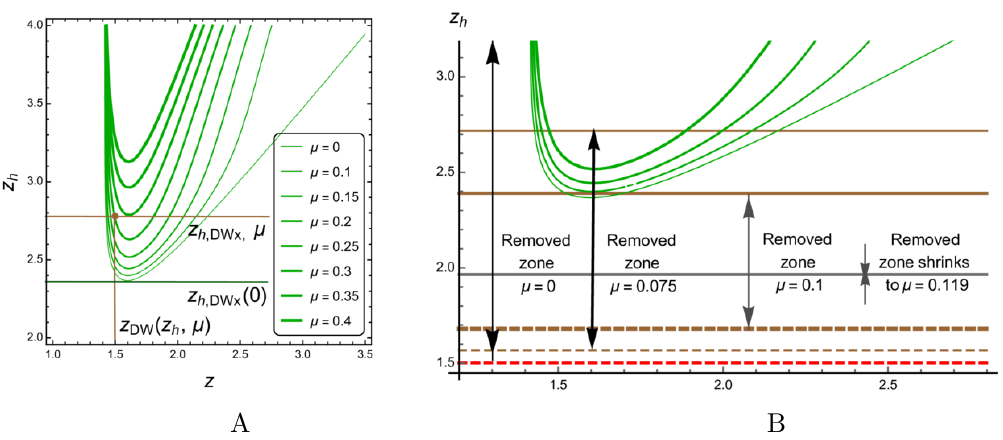
Figure 39 . A) The location of extreme points of the e(cid:11)ective potential in the isotropic case (cid:23) = 1, c = (cid:0) 1 for di(cid:11)erent z h and (cid:22) are shown by green lines with di(cid:11)erent thickness, depending on the values of the chemical potential. Dynamical walls’ positions are located on the left parts of these curves. B) Locations of instability zones corresponding to di(cid:11)erent (cid:22) are shown by the black lines with